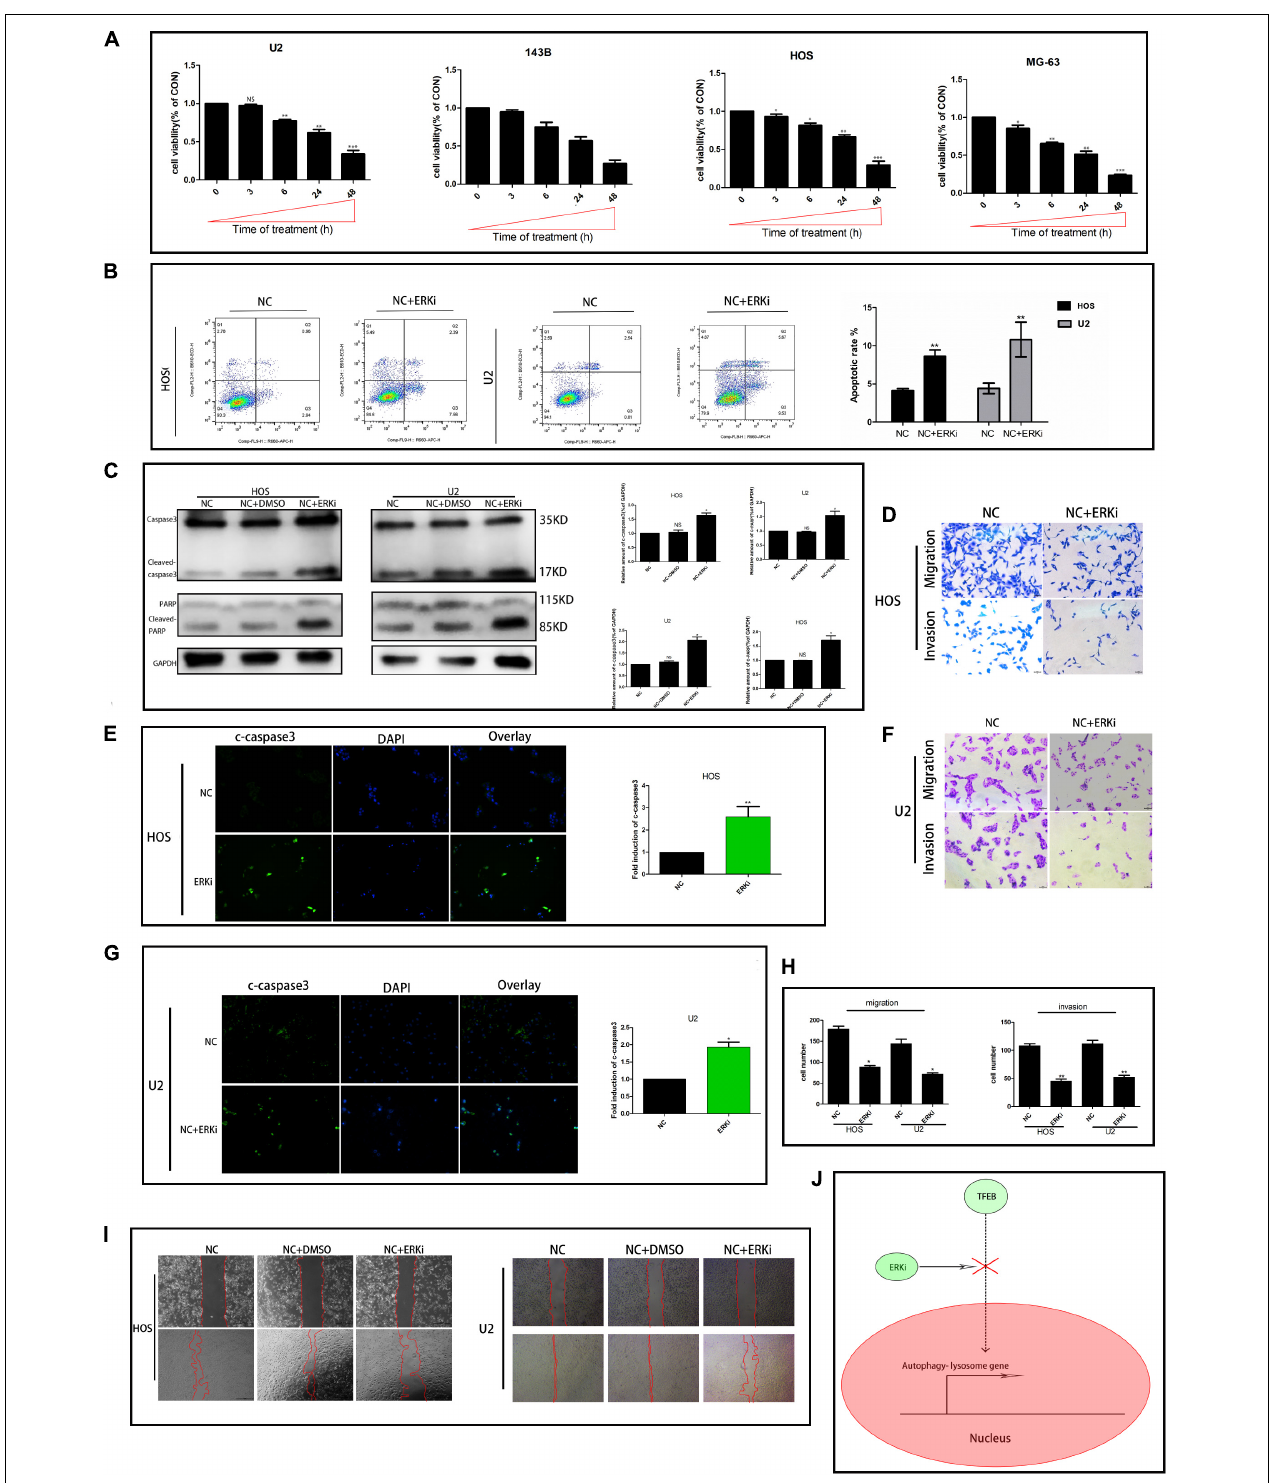
FIGURE 2 | ERK inhibition restrains the activity of OS cells. (A) CCK8 proliferation analysis. (B) Flow cytometry to determine the total proportion of apoptotic cells in OS. (C) Protein expression of caspase3, c-caspase3, c-PARP, and PARP after treatment with ERKi. GAPDH was used as a loading control and for band density normalization. (E,G) Immunofluorescence staining of c-caspase3 (green) in OS cells 24 h after ERKi treatment. (D,F,H) Migration and invasion. (I) Wound-healing assay in different groups. (J) Schematic representation of ERKi effect on autophagy in OS cells. Scale bar = 50 µ m ( n = 5 per group; *** p < 0.001 versus NC group; ** p < 0.01 versus NC group; * p < 0.05 versus NC